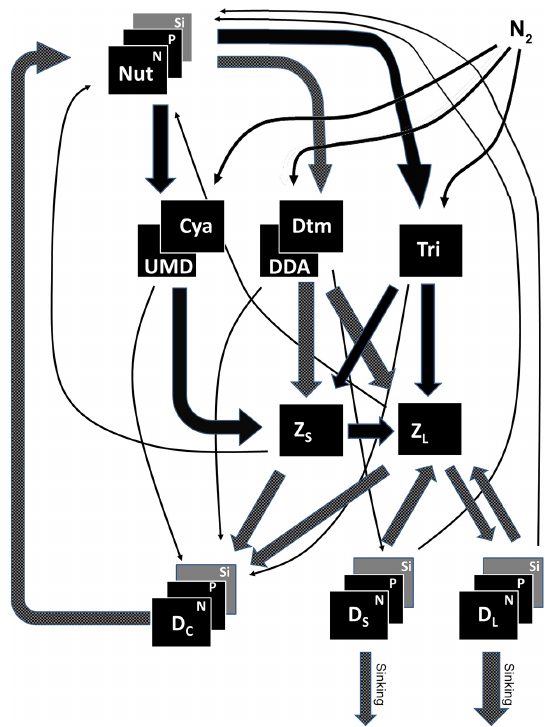
Figure 1. Model description. Model contains 19 biological com- partments: Three nutrients (N, P, Si), five phytoplankton (cyanobac- teria, Cya; unicellular microbial diazotrophs, UMDs; diatoms, DTM; diatom-diazotroph assemblages, DDAs; and Trichodesmium , Tri), two zooplankton (Protozoans, Z S ; and mesozooplankton, Z L ), and three detrital size classes (dissolved and colloidal detritus, D C ; small detritus, D S , and large detritus, D L ) each of which have three different element pools (N, P, Si) to allow variable stoichiometry of the detritus. Arrows depict model flows (transfer functions). Thin black arrows are minor flows. Solid black arrows are flows of only N and P. Hashed black arrows are flows of N, P, and